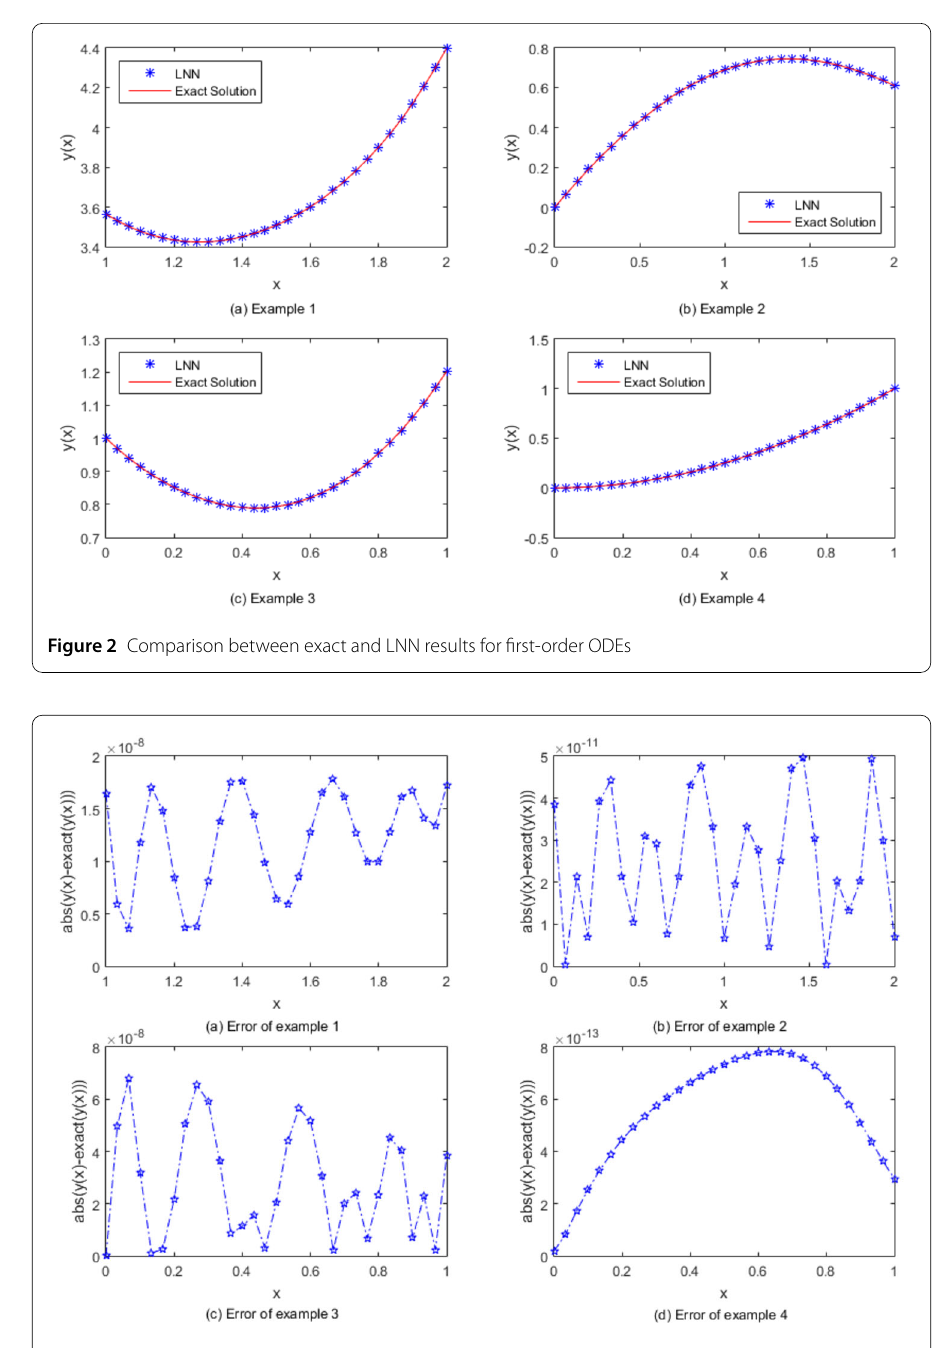
Figure 3 The absolute error for first-order